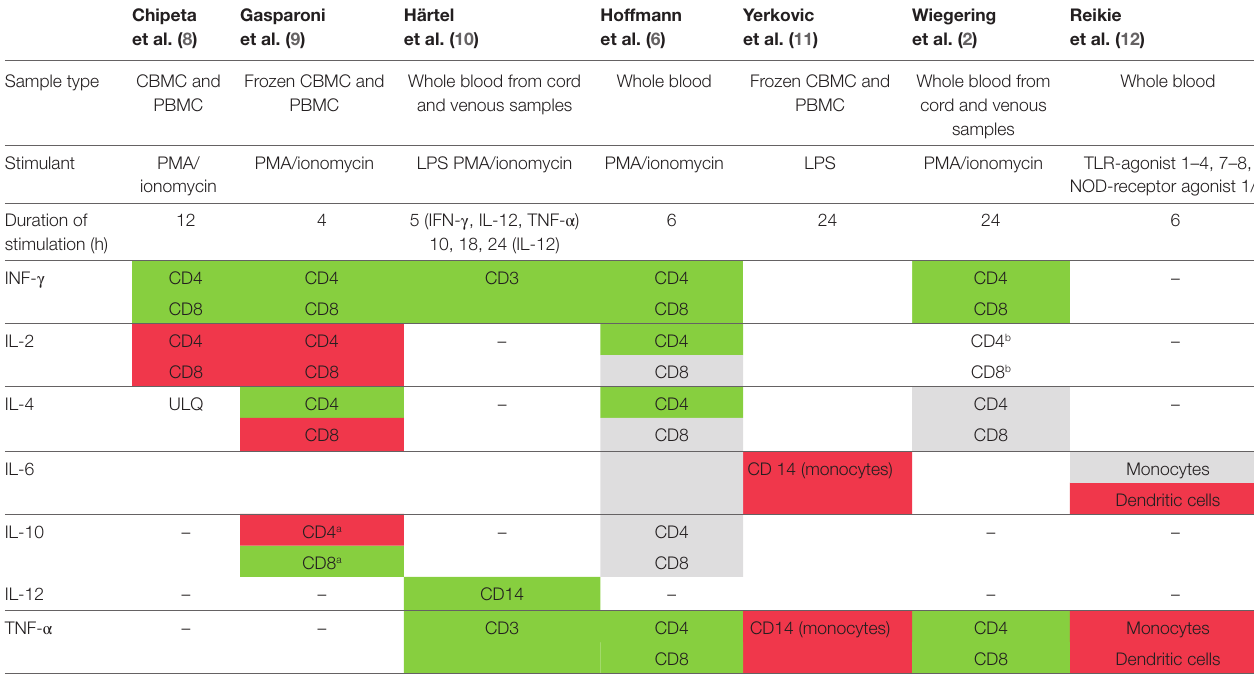
taBLe 4 | Age correlation of cytokine expression in flowcytometry studies. chipeta et al.